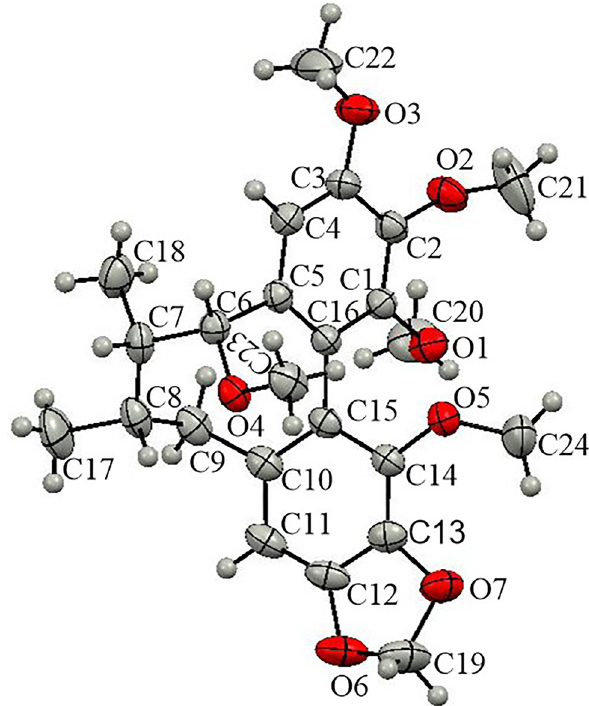
Table  : Data collection and